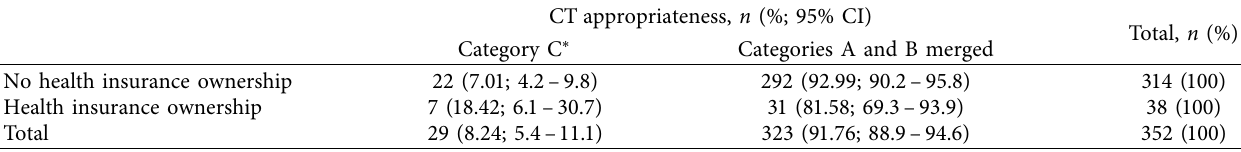
Table 4: Summary analysis of the relationship between CT request appropriateness and health insurance ownership.